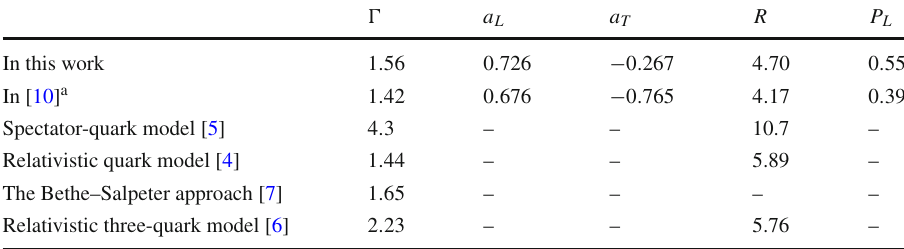
Table 6. The total width (cid:15) and the longitudinal asymmetry Table 6 The widths (in unit 10 10 s − 1 ) and